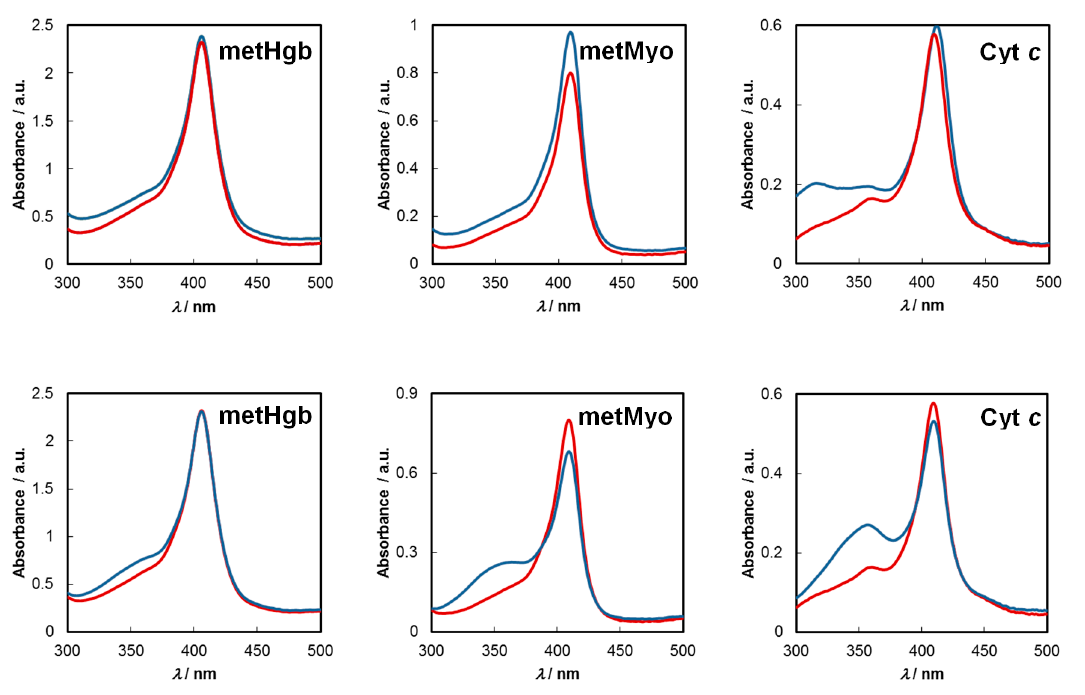
Figure 5. Ground-state absorption spectra for each protein (red line) and the corresponding C-dots–protein complex after subtraction of C-dots’ spectrum (blue line) for C-dots (upper panel) and C-dots/CA (lower panel) at pH = 7.2; [protein] = 6.6 µM.